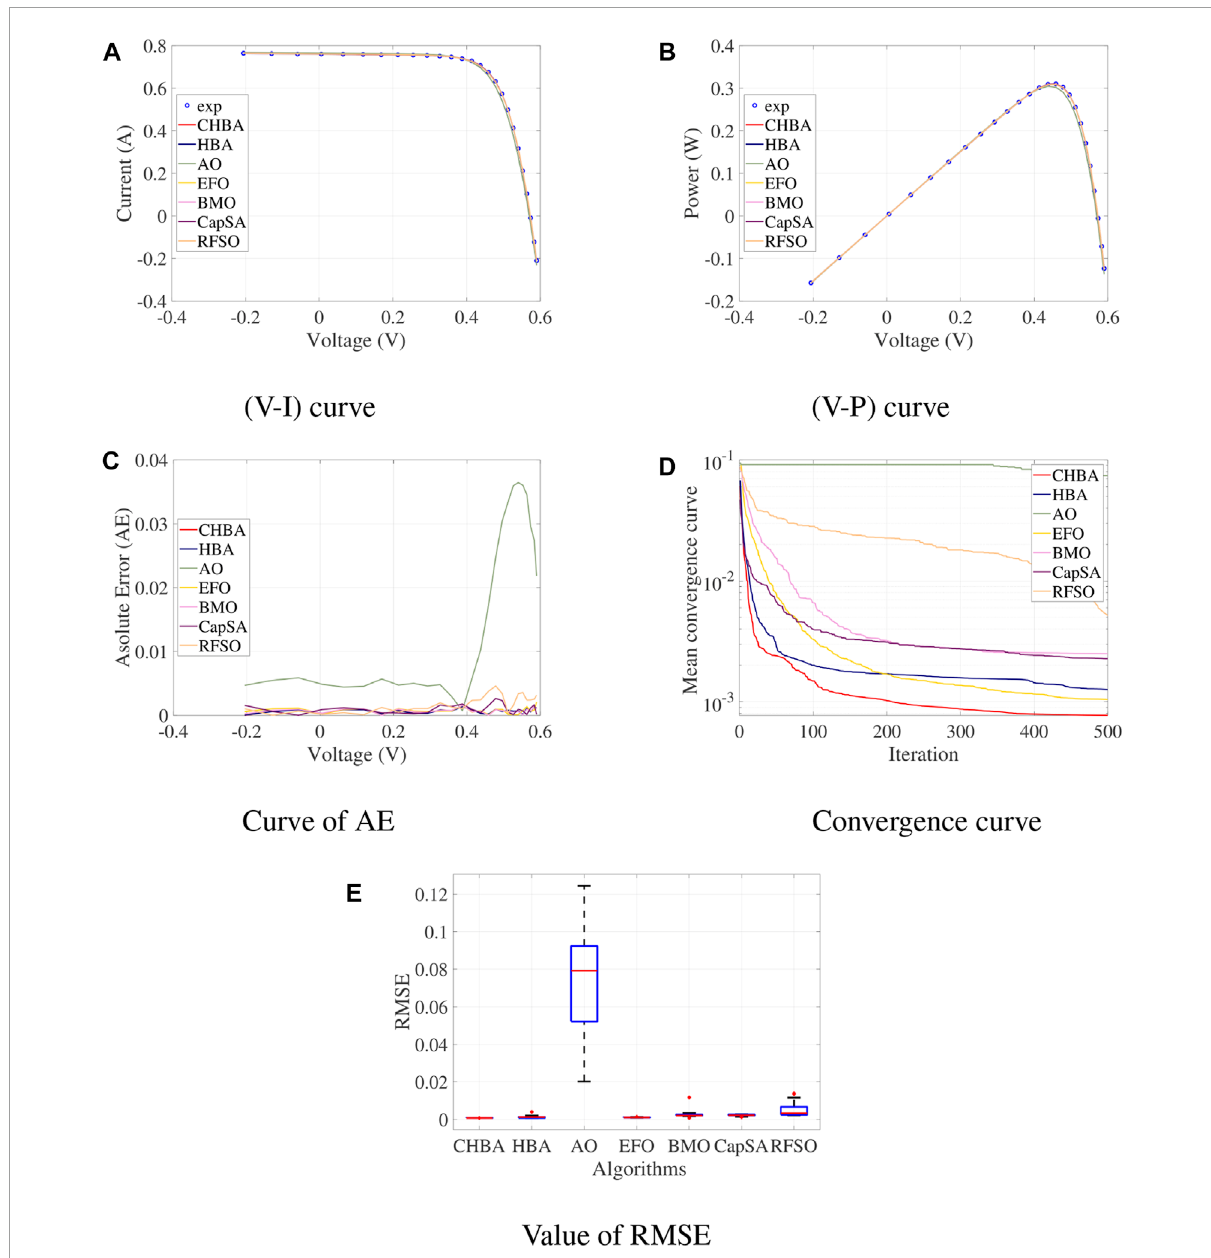
FIGURE 6 Behaviour of competitive techniques using DDM of RTC solar cell.